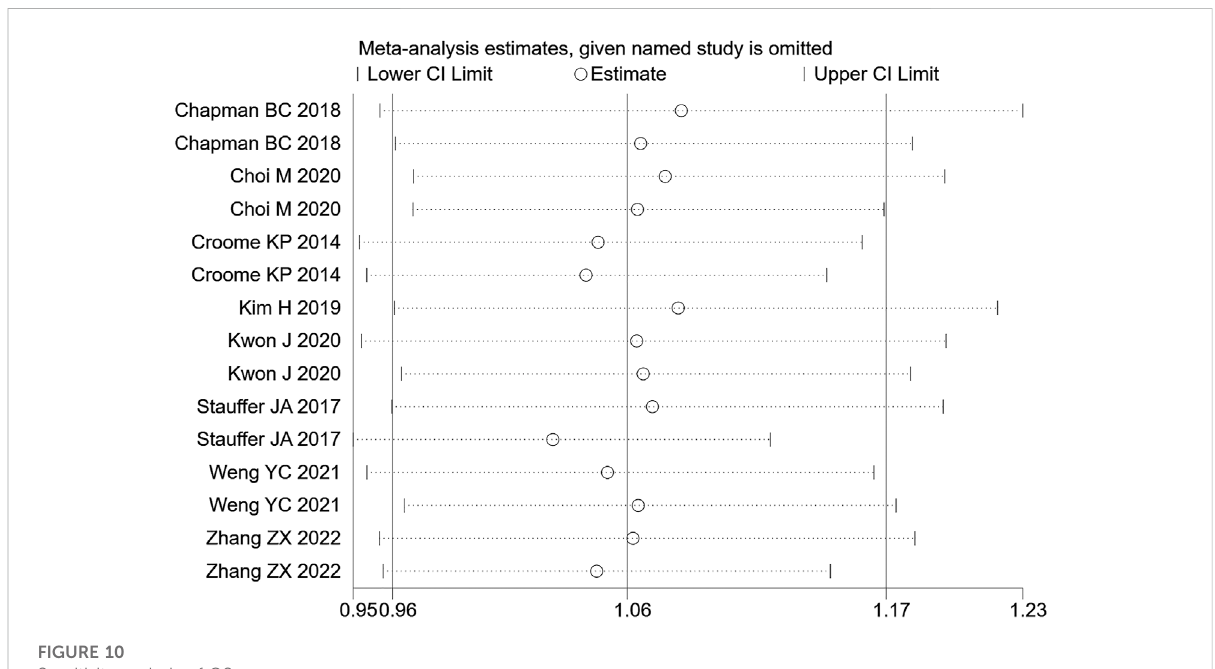
FIGURE 10 Sensitivity analysis of